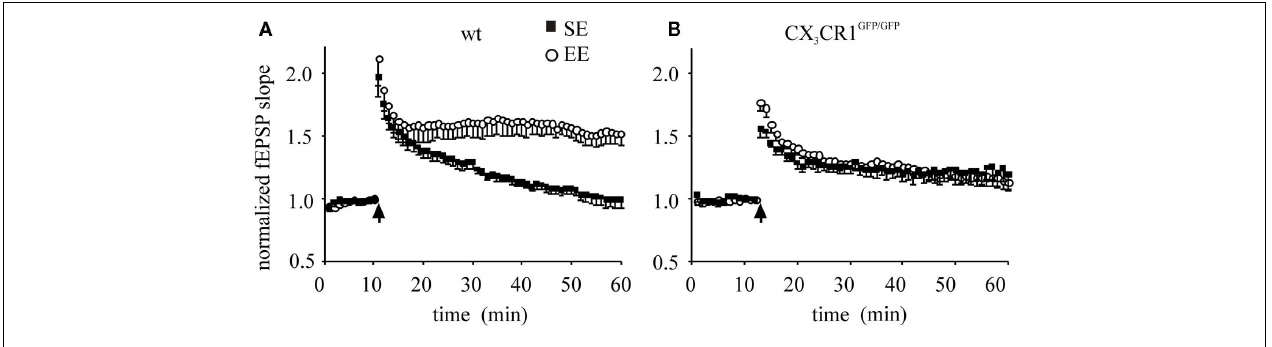
compared to that of mice raised in SE (dark square, p < 0.001). (B) In CX3CR1 GFP/GFP mice LTP is enhanced and EE produced no effect: after HFS, the amplitude of fEPSP potentiation of EE CX3CR1 GFP/GFP mice (open circle) is not different from that obtained in SE mice (dark square). Note that that basal LTP evoked in SE is increased in CX3CR1 GFP/GFP mice compared to wt [in (A) , p = 0.006].